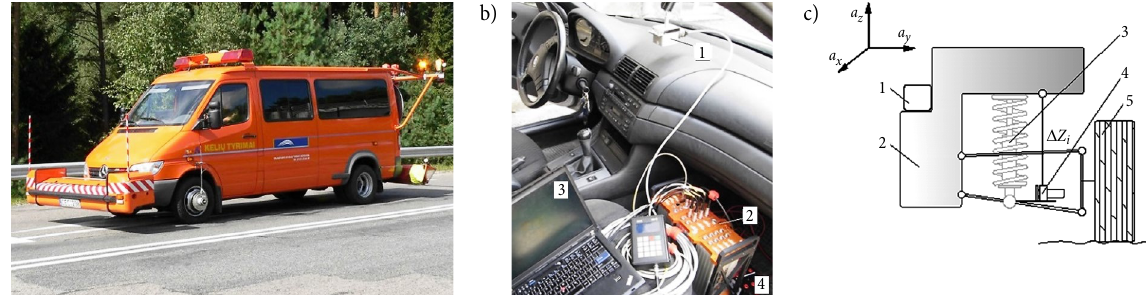
Fig. 3. Equipment used during experimental tests: a – mobile road survey laboratory RST 28; c – scheme for measurement of vehicle dynamical parameters: 1 – 3-axial accelerometer and gyroscope sensor, 2 – sprung mass, 3 – shock absorber and spring, 4 – potentiometer sensor for measuring linear motions, 5 – unsprung